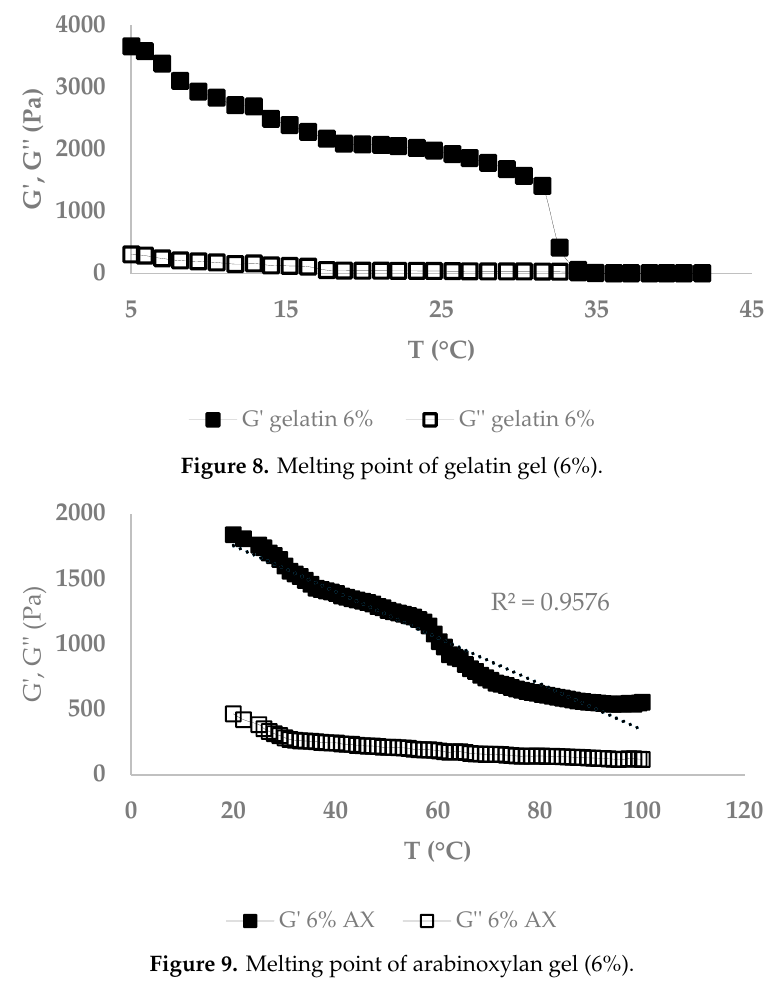
Figure 9. Melting point of arabinoxylan gel (6%).